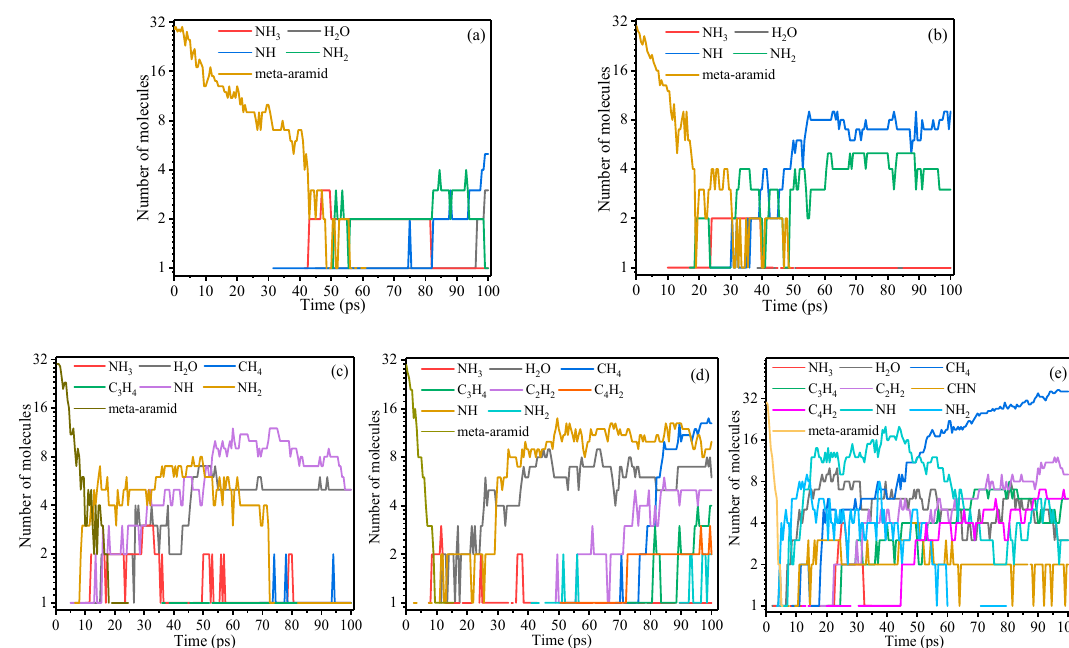
Figure 8. Micromolecular products of meta-aramid fiber at different temperatures: ( a ) 2000 K, ( b ) 2300 K, ( c ) 2500 K, ( d ) 2700 K, and ( e ) 3000 K.